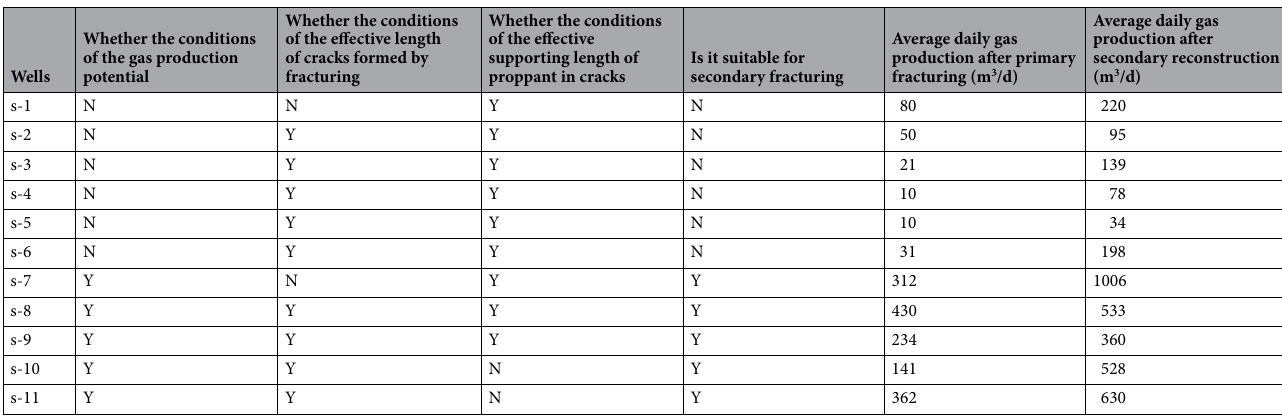
Table 5. Evaluation results of whether 11 wells are suitable for secondary